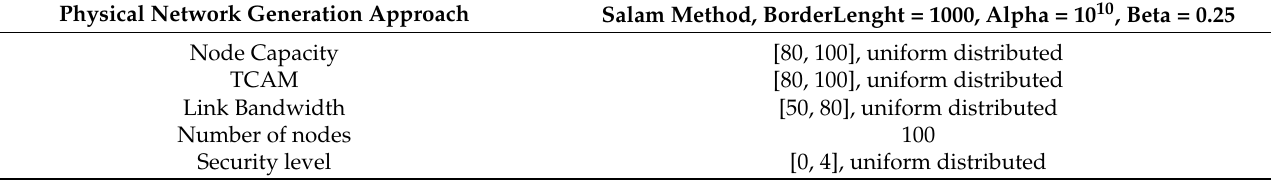
Table 2. Substrate Parameters.